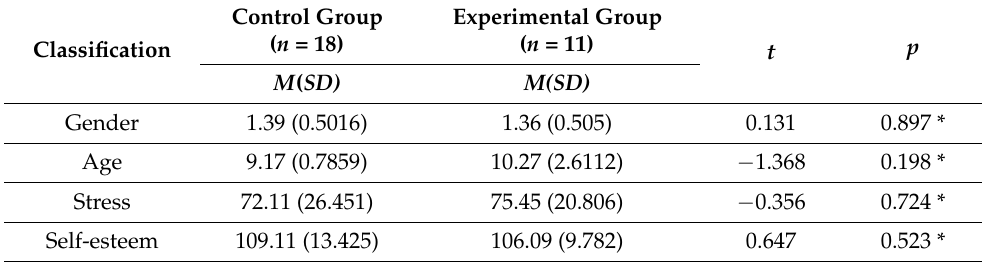
Table 4. Group homogeneity